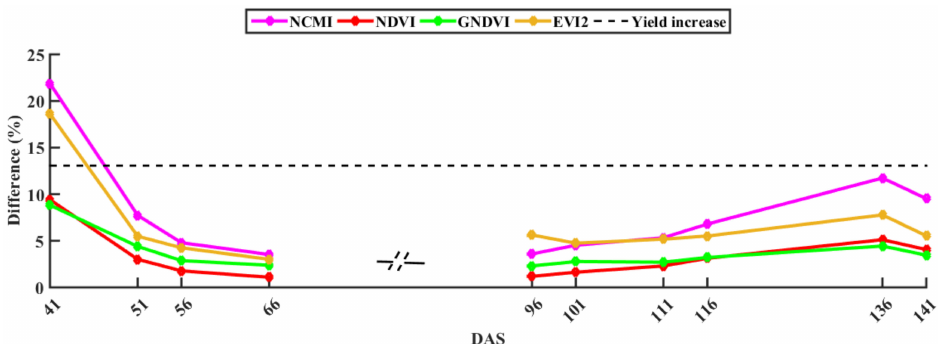
Figure 8. Percentage of difference between the control and GB for the VIs studied on each Sentinel-2 date (for each date and VI, the differences between control and GB are statistically significant ( p < 0.05), except for the NDVI at 66 DAS and 96 DAS (Figure A1)).